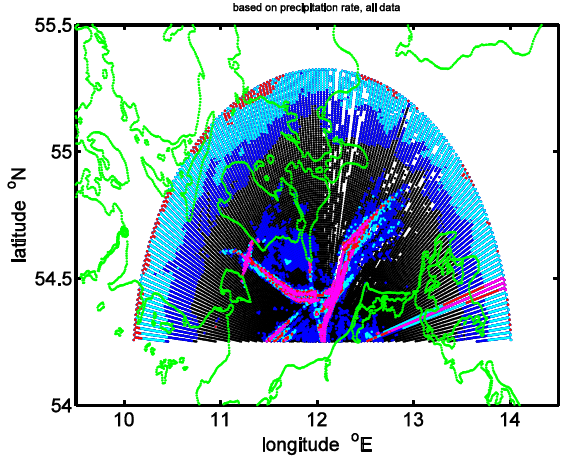
Figure 2. Mean rain rates derived by applying Equation (1) to Rostock radar reflectivities of the volume scan of the lowest available level. The colors indicate data which lie out of the given interval: blue: 0.0475 ± 0.5 × 0.0175 mm·h −1 ; cyan: 0.0475 ± 0.0175 mm·h −1 ; red: 0.0475 ± 1.5 × 0.0175 mm·h −1 ; magenta: 0.0475 ± 2 × 0.0175 mm·h −1 , where 0.0475 mm·h −1 is the total mean and 0.0175 mm·h −1 is the estimated standard deviation of all available weather radar data.